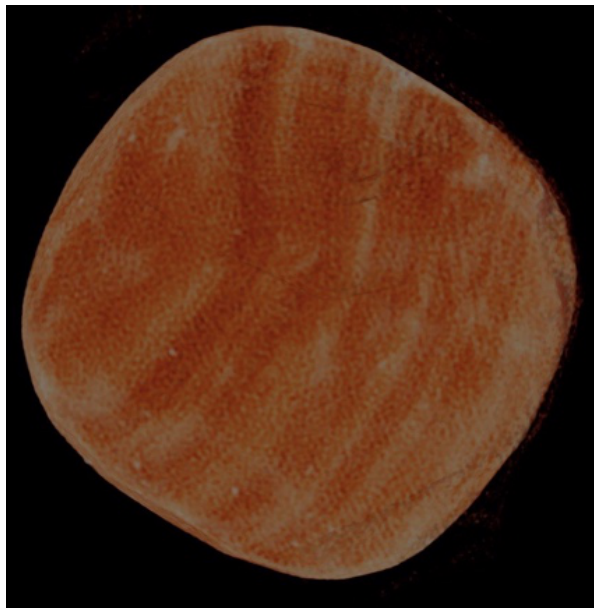
Figure 8. Computed tomography (CT) scan reconstruction of the wooden model. Homogeneity. Largest diameter